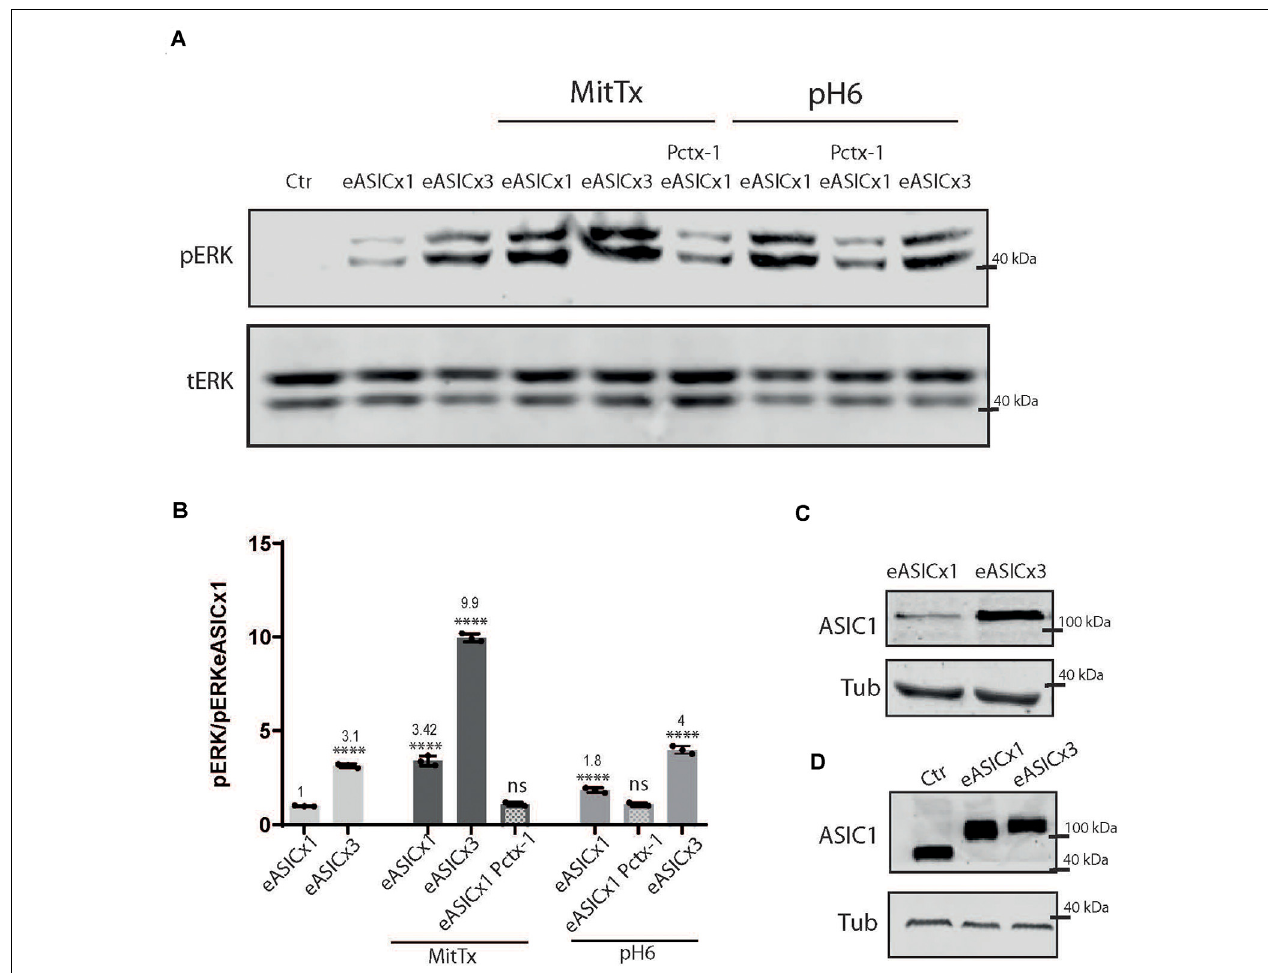
FIGURE 3 | Proton and non-proton activation of overexpressed ASIC1a channels. (A) Representative membranes of lysates of cells control (ctr) or transfected with eGFP-ASIC1a (eASIC) at two levels (1x or x3) to obtained different levels of expression of the protein (“eASICx1 or eASICx3”), and treated with pH6 or MitTx with or without pre-incubation of Pctx-1 or untreated. (B) Plots showing the increase in pERK and pCaMKII levels calculated from membranes as that shown in (A) , consistent with the increase in eASIC expressed. Notice the level of increase achievable via MitTx incubation at the highest overexpressed level of eASIC, higher than that obtained via pH6. (C) Representative membrane showing the different levels of eASIC in cells overexpressing the channel (1x or 3x), detected with an ASIC1 antibody. (D) Comparison between the different ASIC1 proteins expressed (the endogenous human ASIC1a; of approx. 67 kDa) and the overexpressed eASIC (approx. 110 kDa, and expressed at different levels; x1 or x3). (A) Notice that plots are the result of the signal intensity of the band detected,—tERK and tubulin are used as loading controls between loaded samples—and expressed relative to eASICx1 levels. Data are presented as the mean ± SEM ANOVA and Dunnet post hoc test for treatments and conditions were performed, mean values above bars; n = 3 membranes, ∗∗∗∗ p < 0.0001; ns: no significant differences. Mean values expressed relative to eASICx1 levels ± SEM are as follows: eASICx3 3.16 ± 0.06; eASIC MitTx 3.42 ± 0.15; eASICx3 MitTx 9.96 ± 0.12;